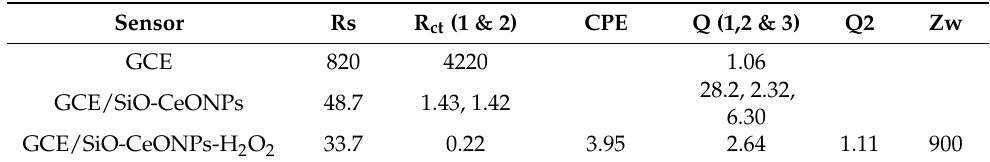
Table 1. Nyquist plot parameters in the presence and absence of H 2 O 2 with χ 2 values between 1.5 and